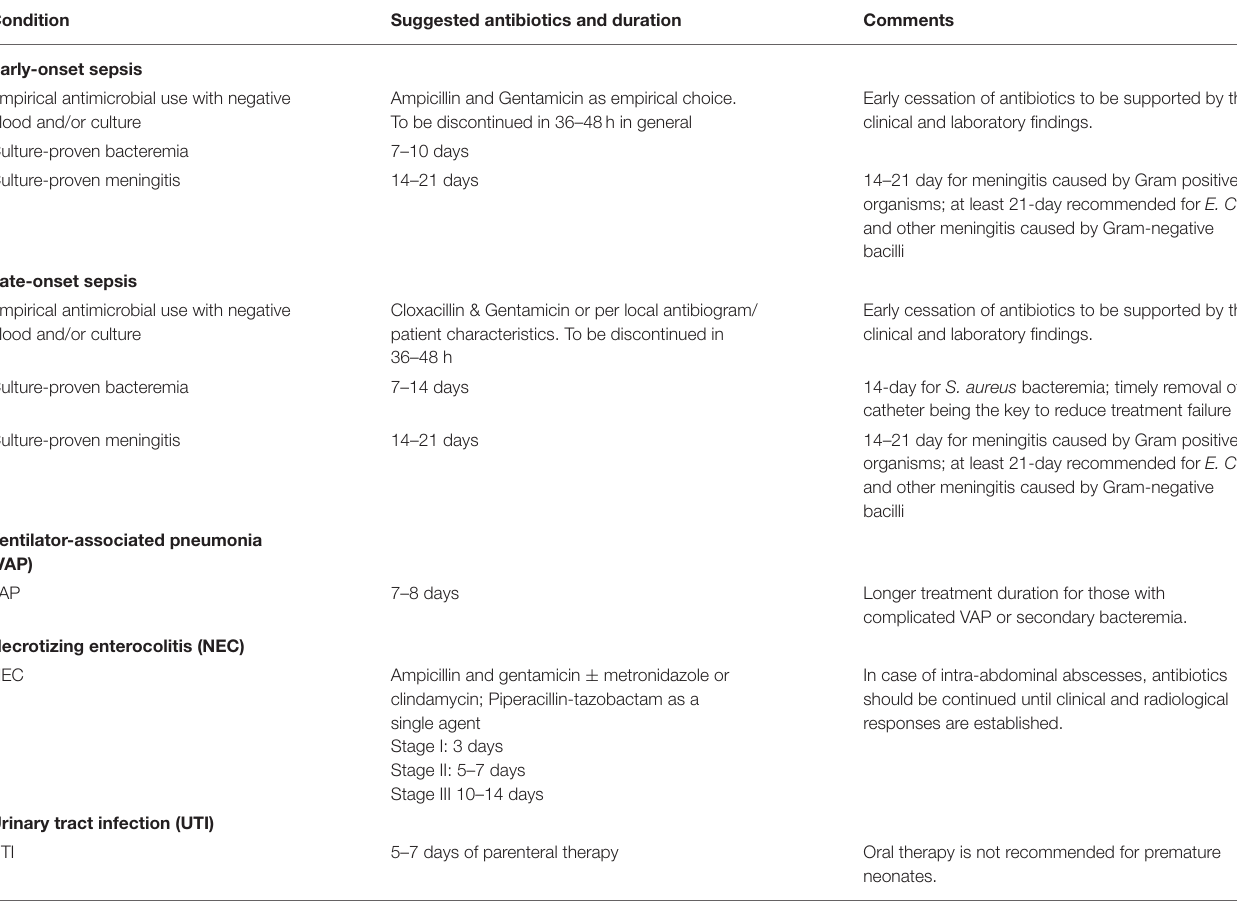
TABLE 1 | Summary of recommendations for agent and duration of antimicrobial therapy for commonly encountered conditions in the NICU.